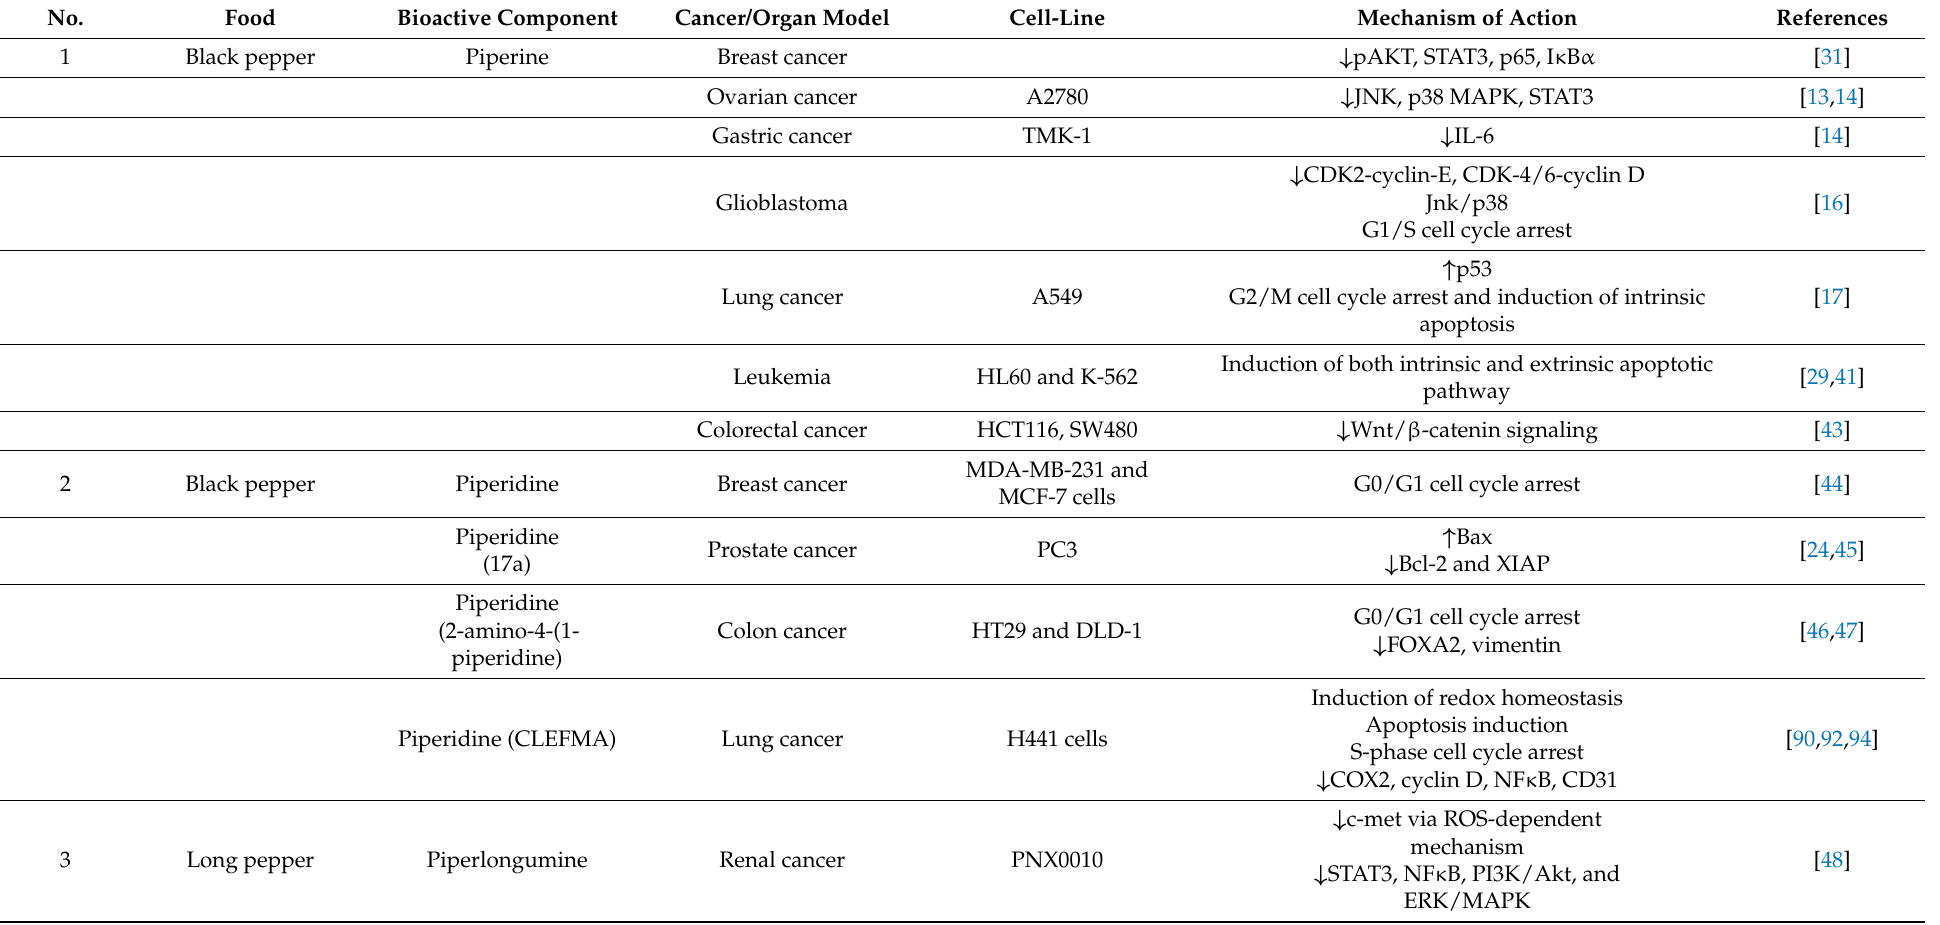
Table 1. Mechanisms of different plant-based food bioactive agents used to treat